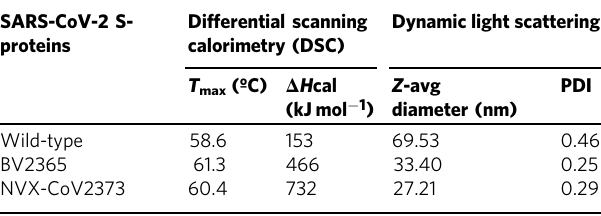
SARS-CoV-2 S stability under stressed conditions . The stability of a COVID-19 vaccine for global distribution is critical. The structural integrity of the NVX-CoV2373 spike protein with the two proline substitutions and BV2365 without the two proline substitutions was assessed with different environmental stress conditions using the hACE2 ELISA. Incubation of NVX-CoV2373